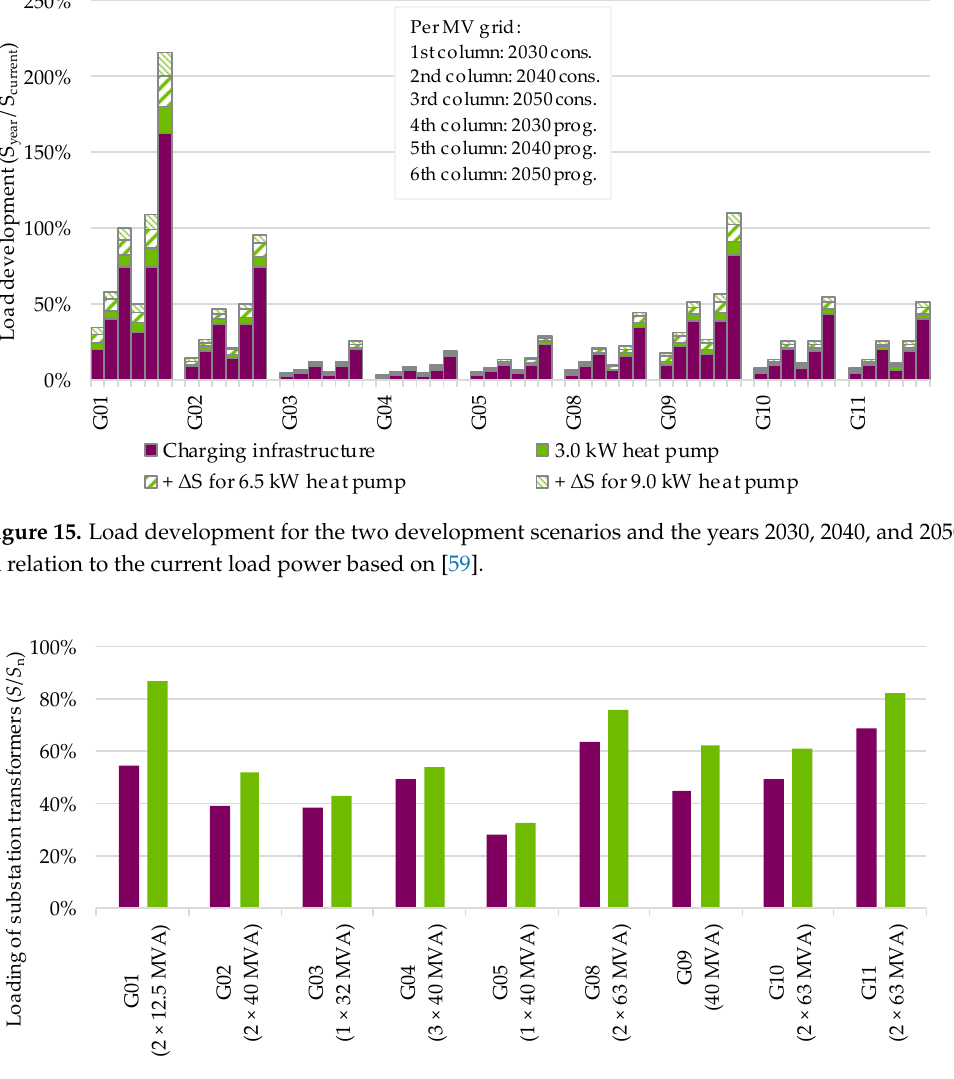
Figure 16. Loading of substation transformers for 9 medium voltage grids in the year 2050 for the two development scenarios.